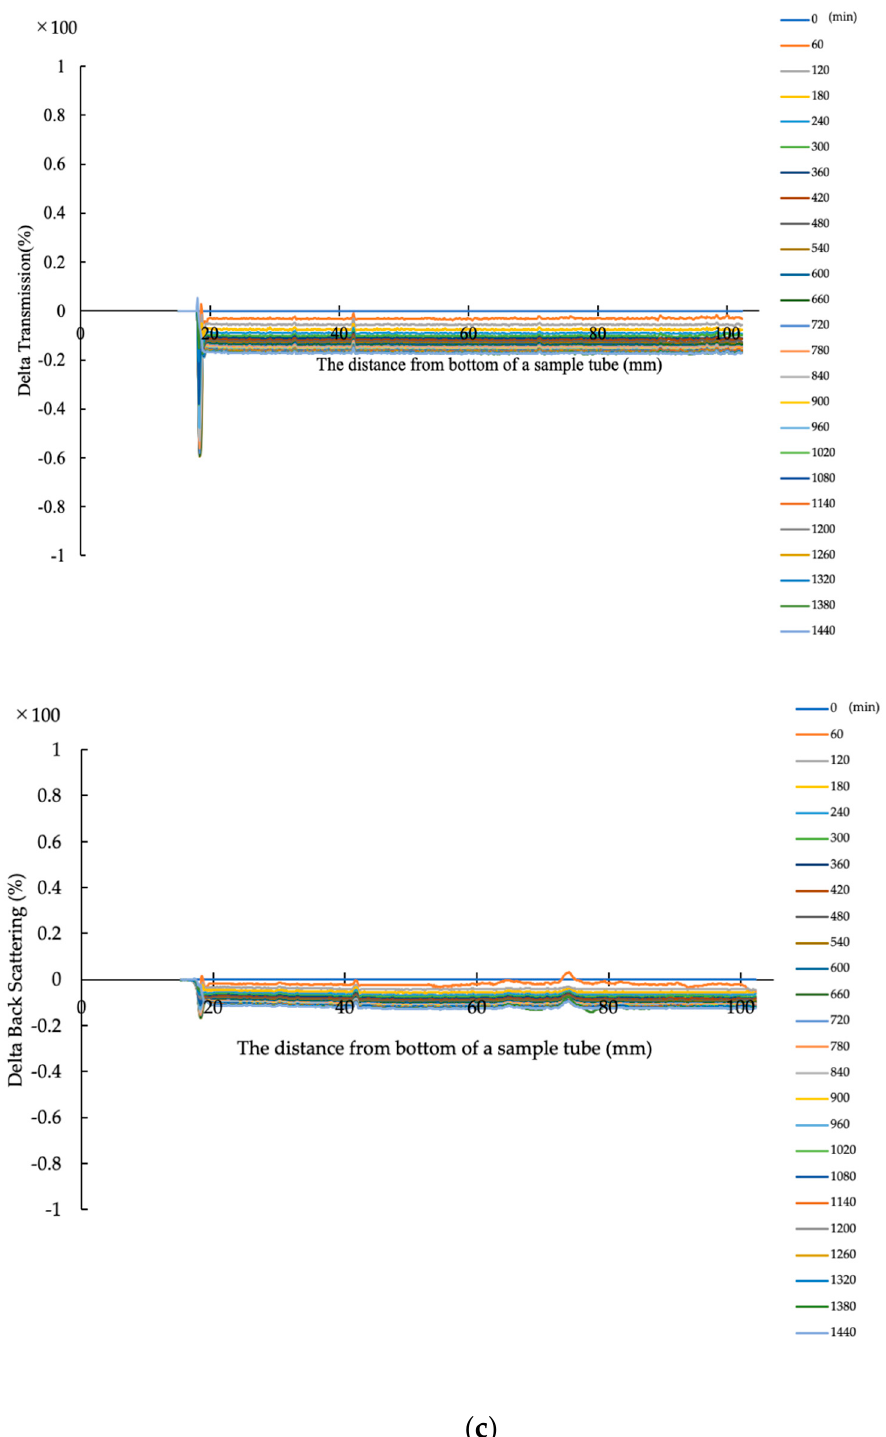
Figure 5. Changes of transmission and backscattering patterns of samples: ( a ) RB mouthwash, ( b ) GM (1:3:1)-45 with HPC-SSL, and ( c ) GM (1:5:1)-30 with PVP K30.